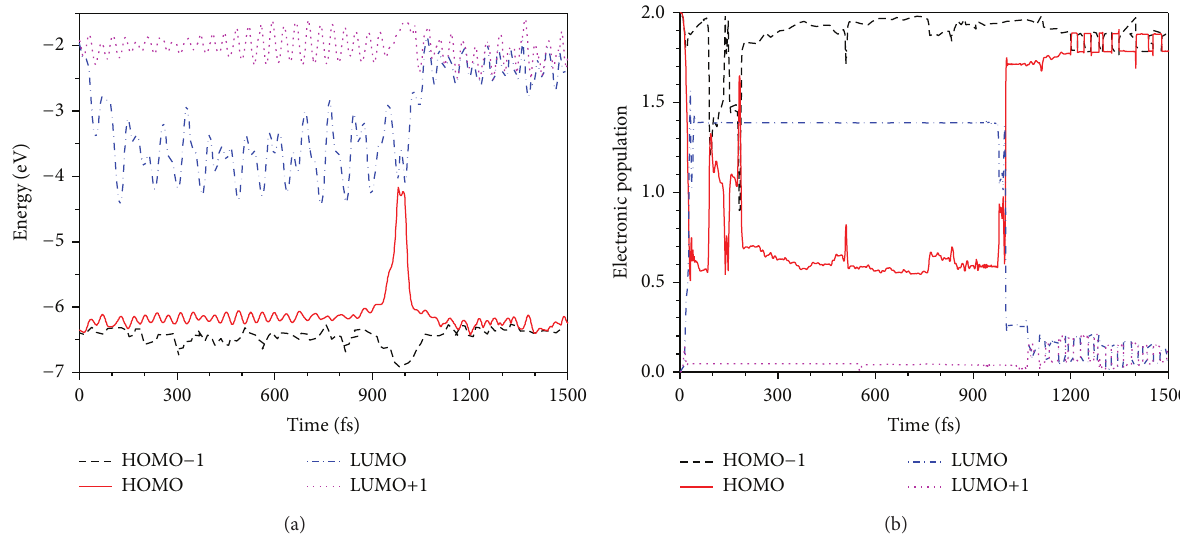
Figure 1: (a) The variations with time (b) the time-dependent populations of the HOMO-1, HOMO LUMO, and LUMO+1 energies of two stacked cytosine